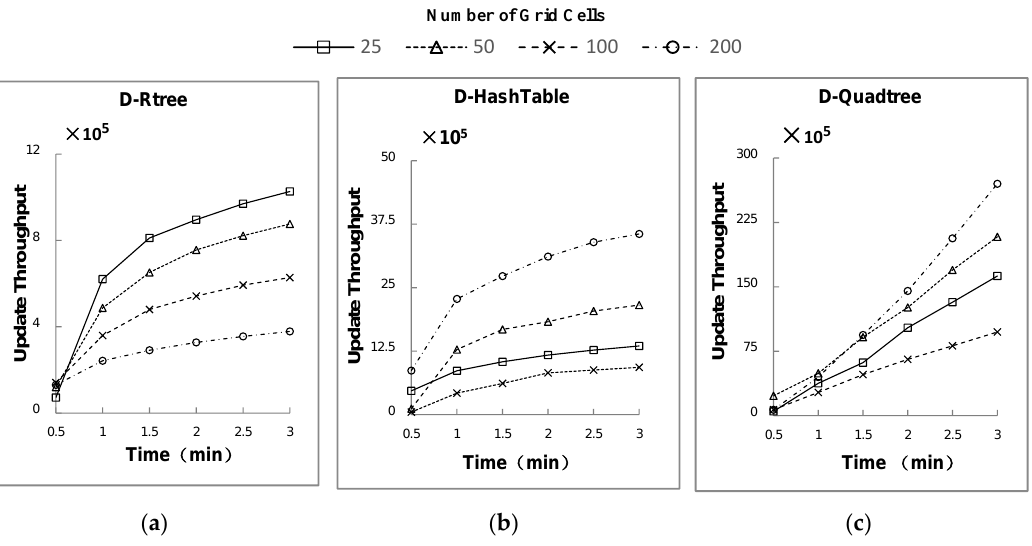
Figure 10. Effect on the update throughput of different partition sizes over time. ( a ) Update throughput of D-Rtree; ( b ) update throughput of D-Hahtable; ( c ) update throughput of D-Quadtree. Study 4: Influence of the query range size on the spatial join performance